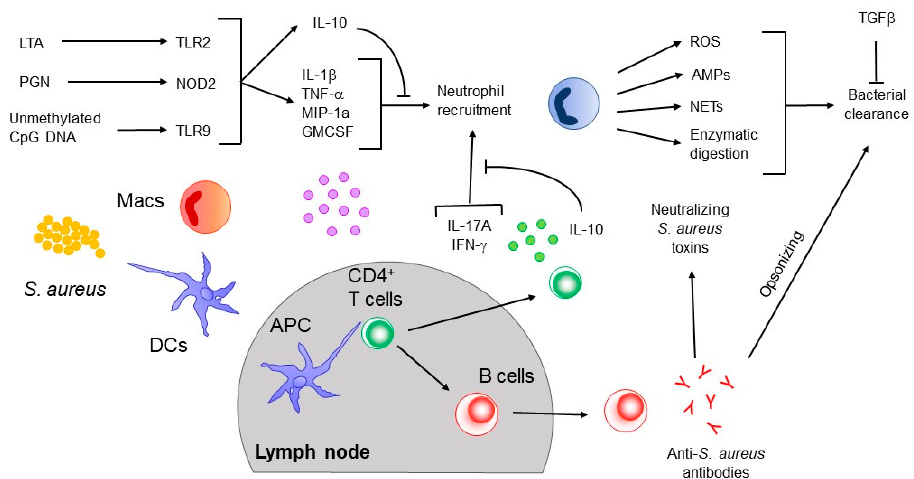
Figure 1. The immune response against S. aureus . Pattern recognition receptors (TLR2 / NOD2 / TLR9) expressed on innate immune cells such as macrophages (Mac) and dendritic cells (DC) at the infection site respond to S. aureus pathogen-related molecular patterns (LTA, peptidoglycan (PGN), and unmethylated CpG DNA). This interaction leads to the release of cytokines and chemokines (IL-1 β , TNF- α , MIP-1 α , and GM-CSF), which attracts neutrophils to the site of infection. Neutrophils mediate killing and clearance via reactive oxygen species (ROS), anti-microbial peptides (AMPs), neutrophil extracellular traps (NETs), and enzymatic digestion by hydrolases and proteinases. After interacting with S. aureus, Mac and DC can migrate to draining lymph nodes to present the antigen to naïve T cells. This interaction causes T cells to undergo functional di ff erentiation, which culminates with the generation of IFN γ and IL-17-producing cells. IFN γ can activate Mac and DC to enhance antigen presentation (among other inflammatory functions). The expression of IL-17 facilitates neutrophil recruitment. The anti-inflammatory cytokines TGF β and IL-10 can also be induced upon infection and could play both protective (limiting damage) or inhibitory (limiting immune response) roles, depending on the route of infection. Additionally, T FH cells could di ff erentiate in response to the initial infection and could interact with B cells so as to foster the production of anti-staphylococcal antibodies that enable the opsonization of bacteria or neutralize staphylococcal